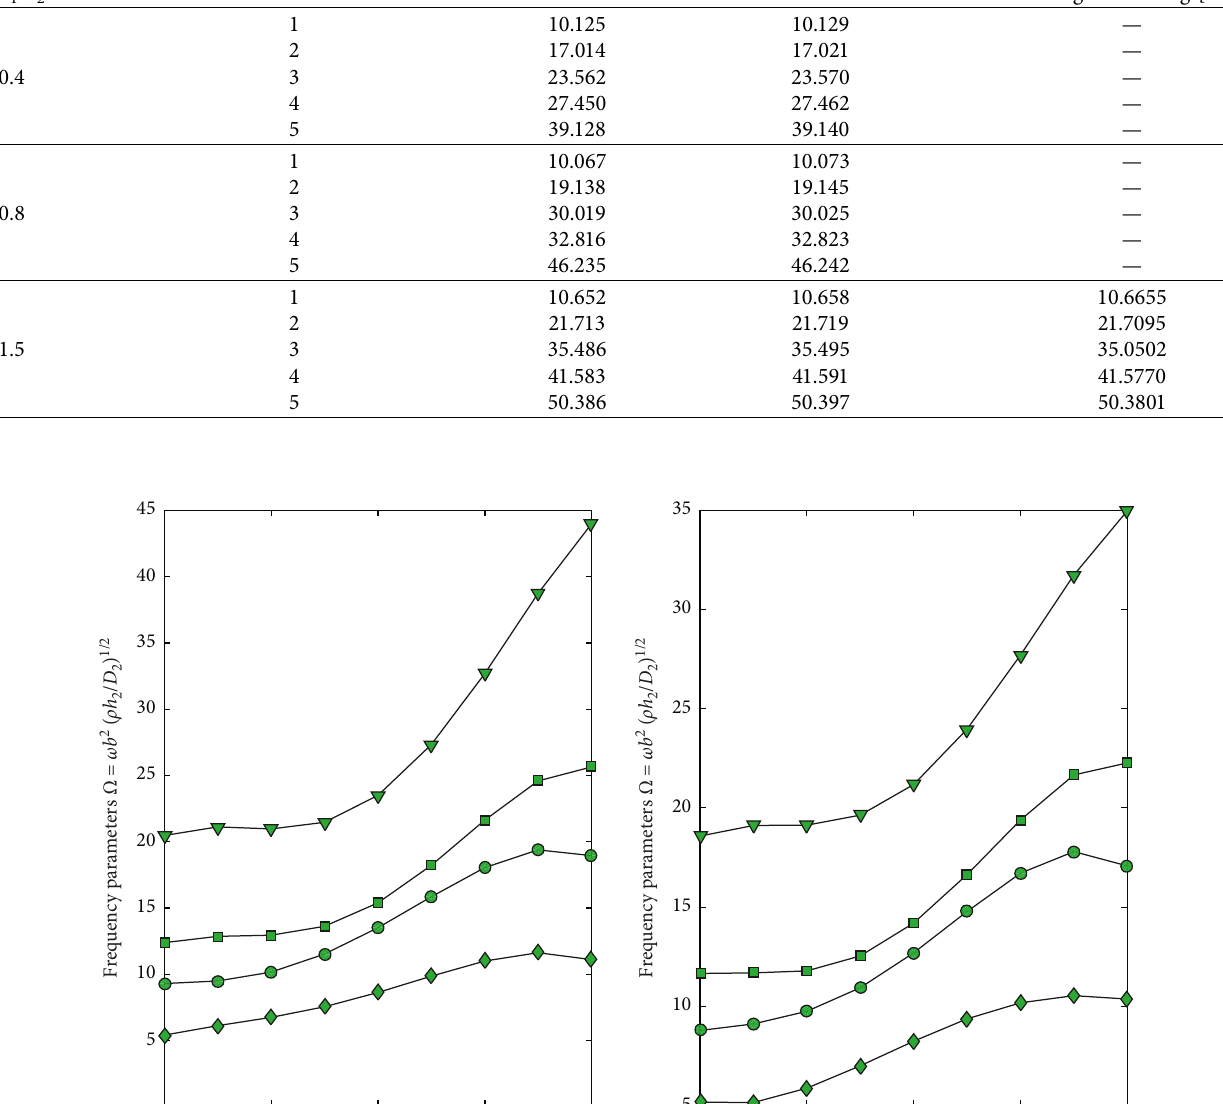
Figure 3: Frequency parameters Ω � ω b 2 � 2, and plate thickness ratios h / h ratio h 1 2